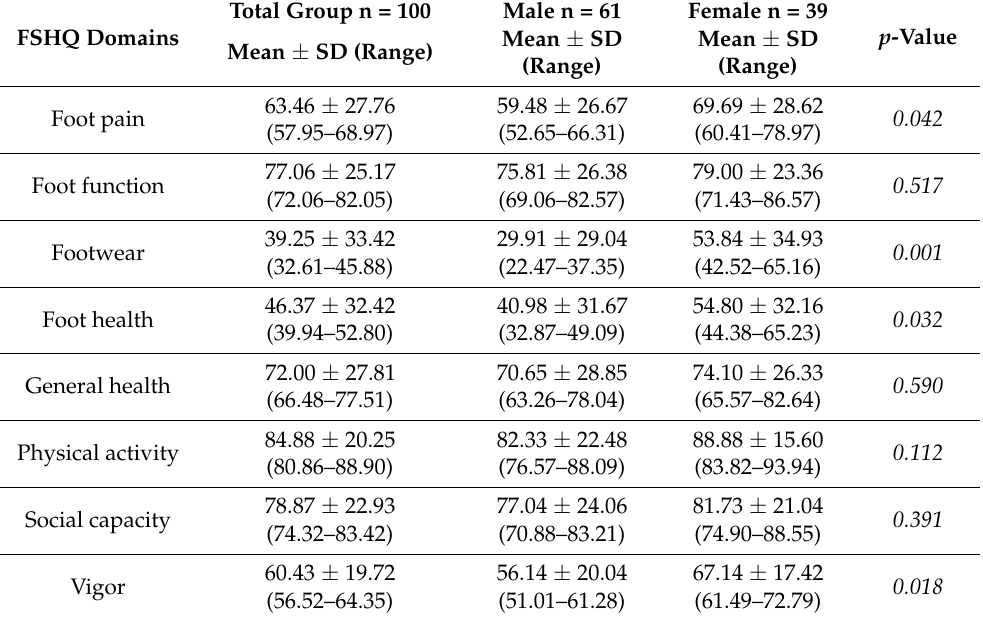
Table 5. Comparisons of Foot Health Status Questionnaire scores by sex.